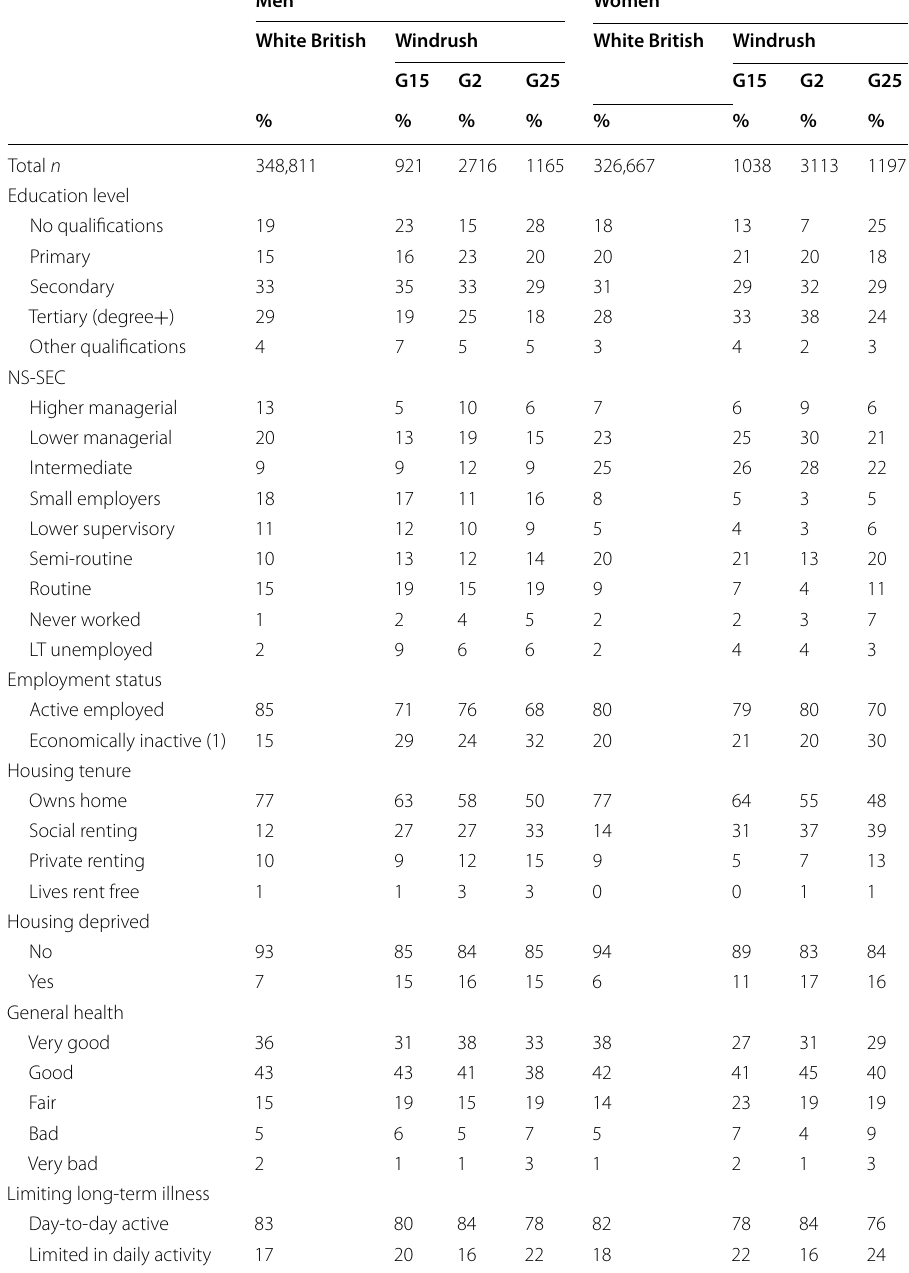
Table 4 Distribution of the core socio‑economic variables by both generation and sex. Source : Authors’ calculations based upon 5% microdata sample of resident population of England and